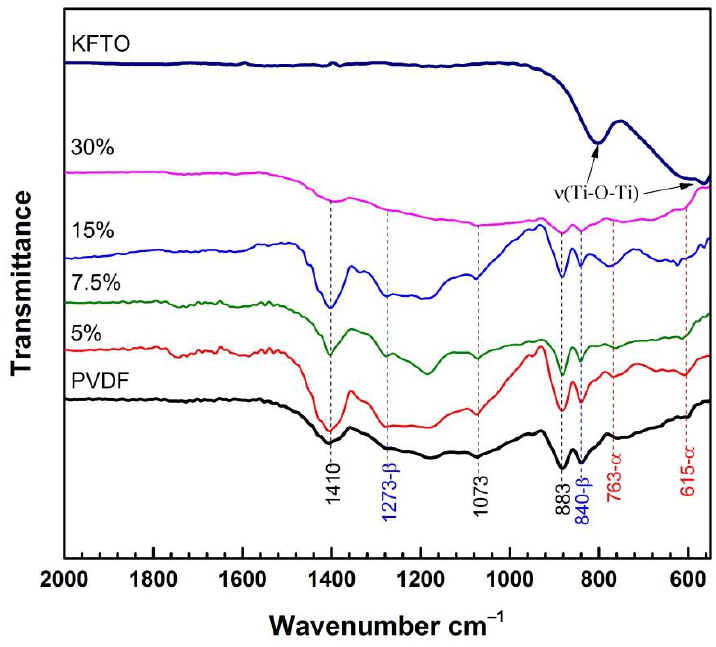
Figure 4. FTIR of the KFTO(H)/PVDF